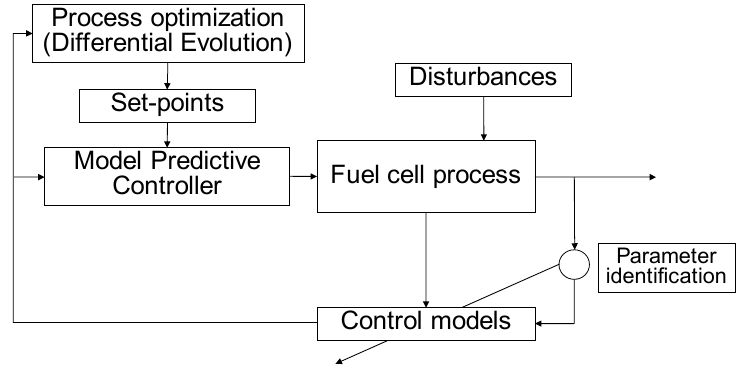
Figure 1. A control framework for the simulated fuel cell process.